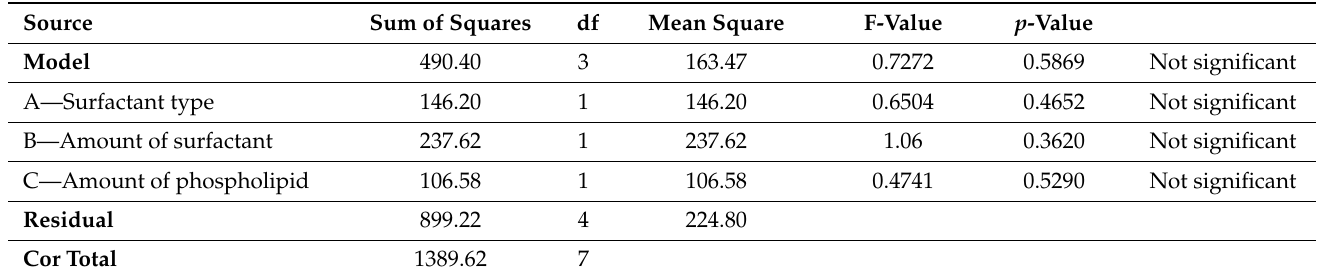
Table 6. ANOVA analysis for the effect of formulation factors on the Zeta potential